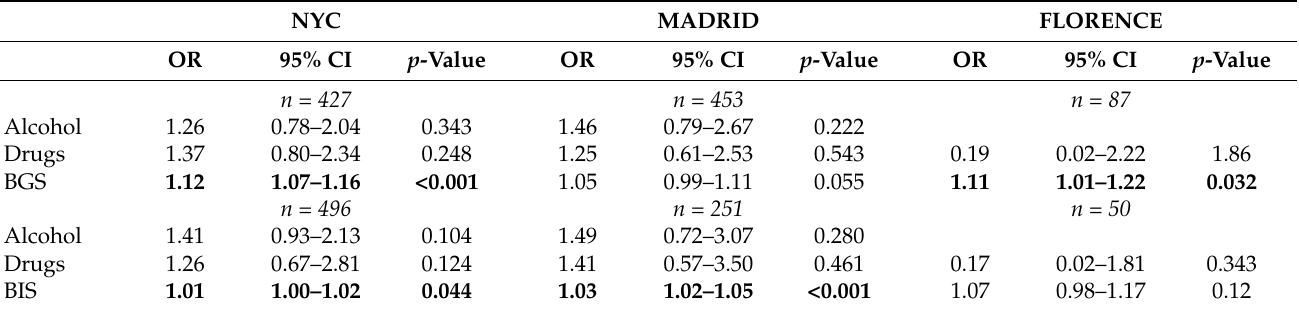
Table 4. Binary logistic regression on previous